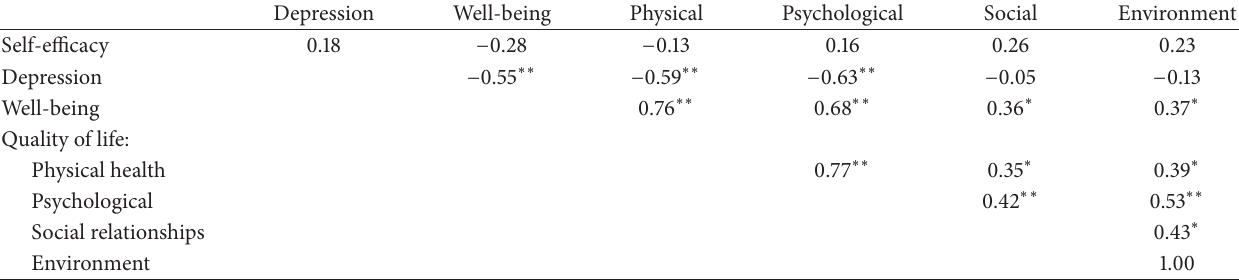
Table 3: Correlations of self-efficacy, depression, well-being, and quality of life among older PLWHAs. Depression Well-being Physical Psychological Social Environment